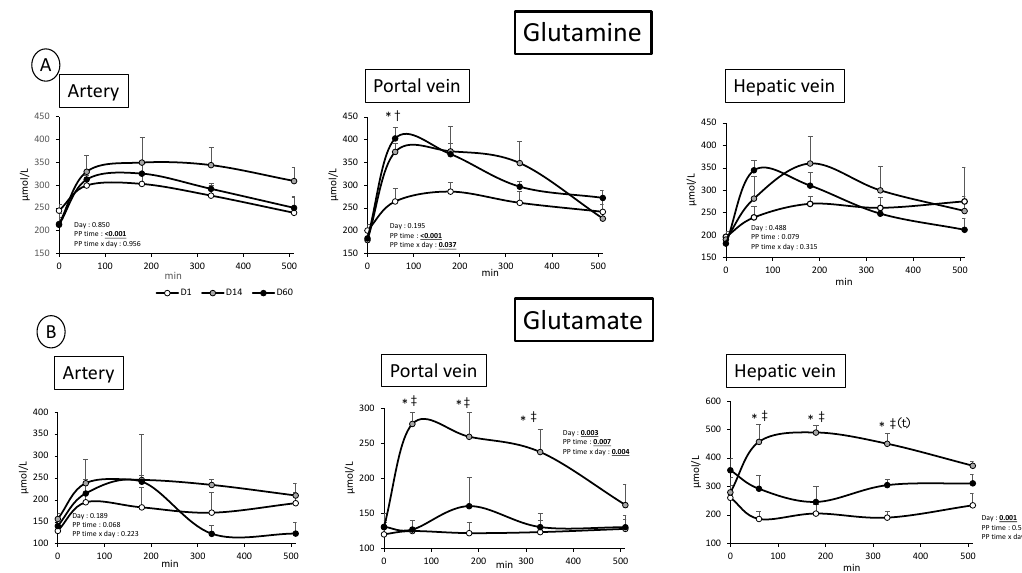
Figure 4. ( A ) Glutamine concentration ( µ mol/L) after meal intake (post prandial state, PP: 0 to 510 min) in artery, portal vein and hepatic vein; and ( B ) glutamate concentration ( µ mol/L) after meal intake (post prandial state, PP: 0 to 510 min) in artery, portal vein and hepatic vein; before (D1) and after 14 days (D14) and 60 days (D60) of adaptation to HFHS diet. Two way RM ANOVA, * D14 significantly different from D1, † D60 significantly different from D1, ‡ D60 significantly different from D14; Values are means ± SEM. For calculations and statistical treatment of the data and for details, see Materials and